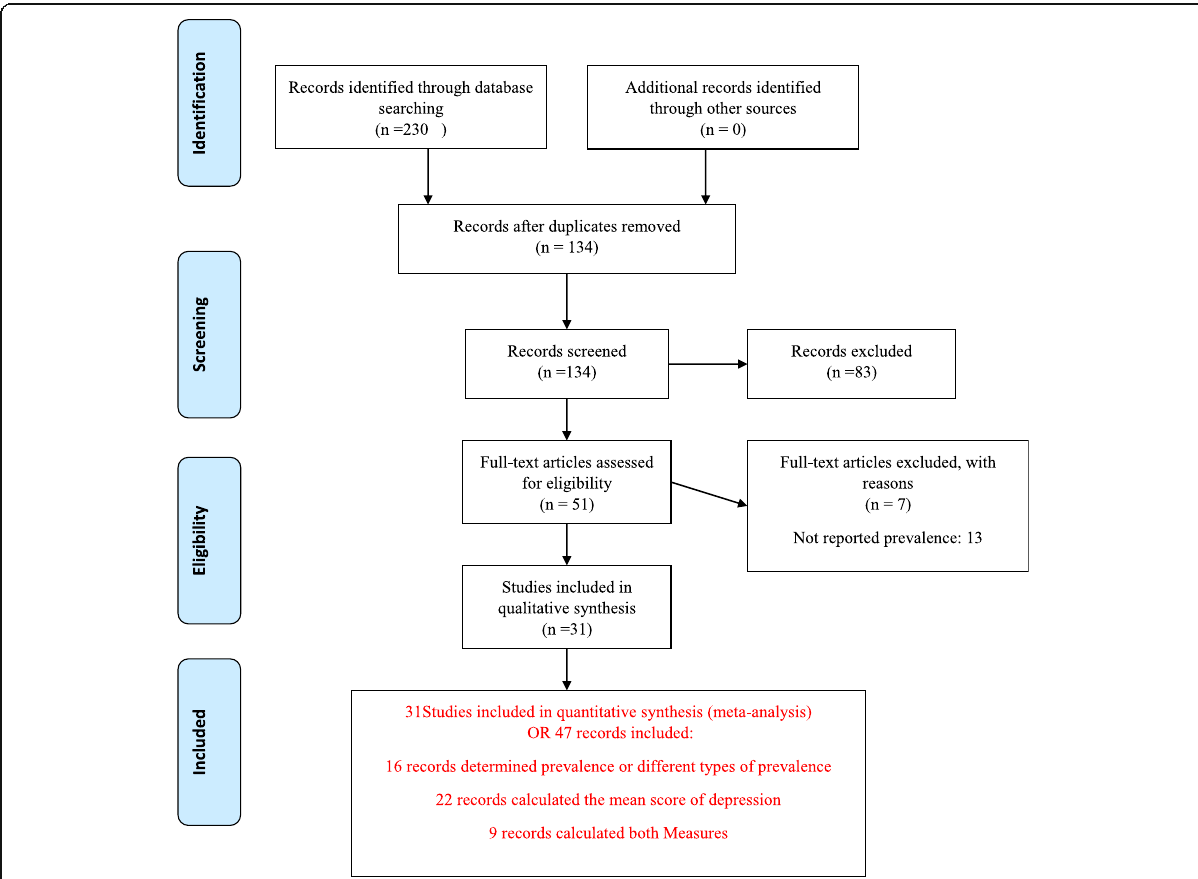
Fig. 1 The process of searching and selection of